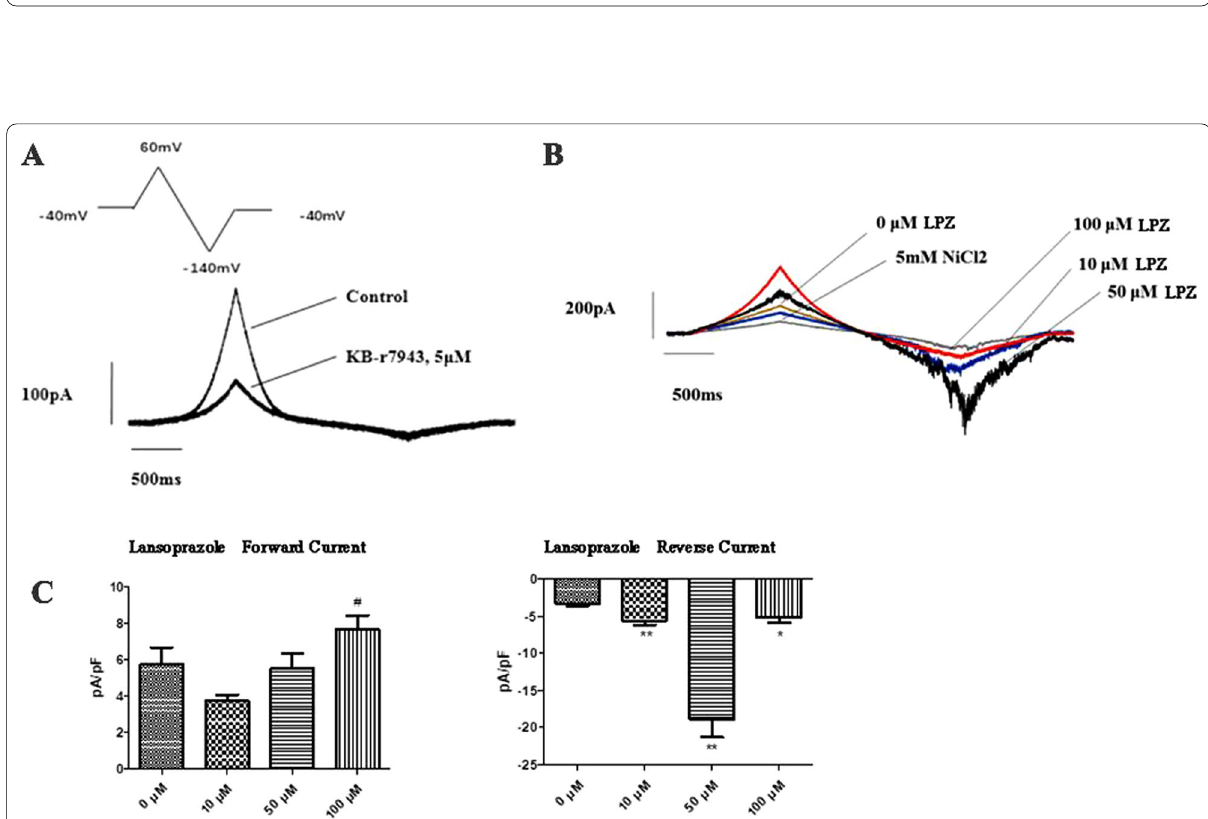
Fig. 8 [Ca 2 + ] i after longterm treatment with LPZ and TG. A [Ca 2 + ] i levels in MC3T3-E1 cells that were preincubated with TG in calcium-containing medium, as detected by flow cytometry. B Quantitative analysis of [Ca 2 + ] i after treatment with LPZ or TG for 24 h (n